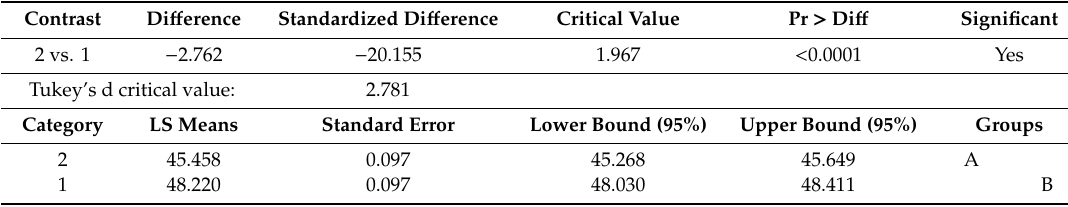
Table 5. Tukey’s HSD test results for the TRS yield (%). Analysis of the di ff erences between the two reaction media with a confidence interval of 95%. “1” stands for the pretreatment medium with sulfolane-TiO 2 and “2” for the medium without it.